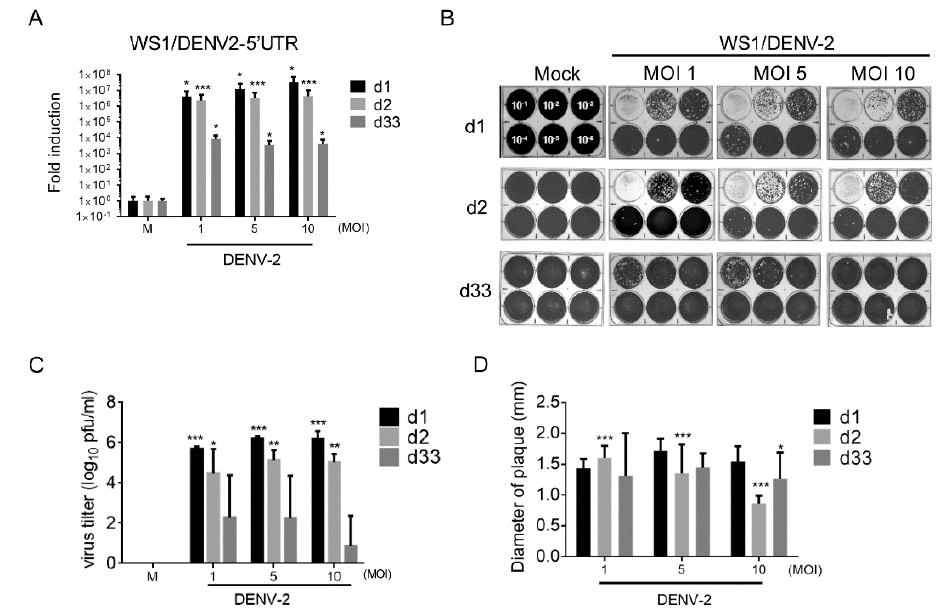
Figure 2. DENV ‐ 2 RNA replication and virion production in WS1 cells after long ‐ term culture. ( A ) 4 × 10 4 WS1 cells were infected with DENV ‐ 2 MOI 1, 5, and 10; the DENV ‐ 2 RNA ( 5 ′‐ UTR) replication was detected by qRT ‐ PCR on days 1, 2, and 33 post ‐ infection. The DENV ‐ 2 RNA expression was normalized to the Gapdh gene and the fold induction to mock control. Data are presented mean ± SD from three independent tests. ( B ) The culture medium of DENV ‐ 2 ‐ infected WS1 cells were harvested and diluted (dilution factor: 10 − 1 to 10 − 6 ) for plaque assay. ( C ) The virus yield by WS1 cells and quantified in plaque assay are presented in log 10 plaque ‐ forming units per milliliter (PFU/mL) from three independent assays. ( D ) The diameter of the plaque size in DENV ‐ 2 plaque assay was measured using Image J software (imagej.nih.gov). Data are presented mean ± SD, * p < 0.05, *** p < 0.001, *** p < 0.005 vs. mock control.